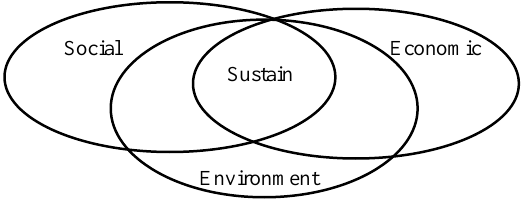
Figure 1: Three pillars of sustainable development (Source: Green et al.,